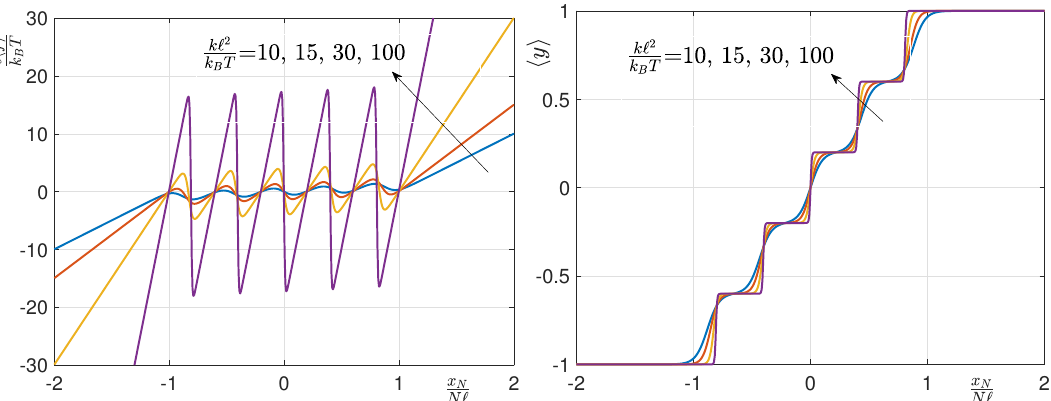
Figure 3. Average force-extension curves and average spin variables (plotted by means of dimensionless quantities) for the Helmholtz ensemble with N = 5 and k (cid:96) 2